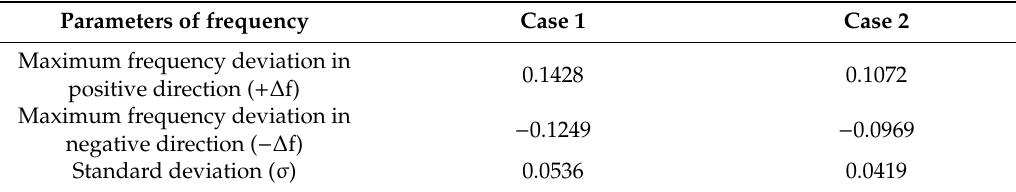
Table 1. Comparison of di ff erent parameters of the frequency response graph.